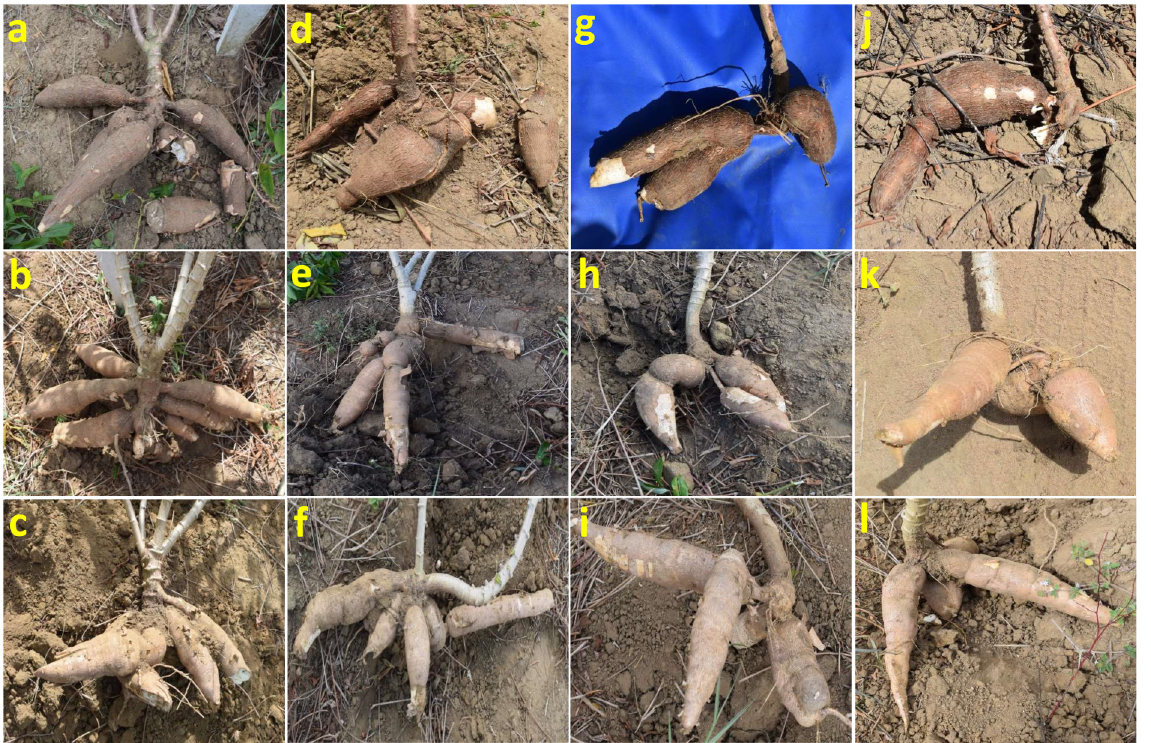
Figure 1 - Overview of the roots from different cassava varieties and origins of the propagation material. ( a , b and c ): roots from conventional propagation, i.e., stem cuttings with of 20 cm; ( d, e and f ): roots from leaf bud plants from the upper position of the mother plants; ( g , h and i ): roots from leaf buds from the middle position of the mother plants; ( j , k and l ) roots from leaf buds from the inferior position of the mother plants; ( a , d , g and j ): BRS Kiriris variety; ( b , e , h and k ) 98150-06; and ( c , f , i and l )